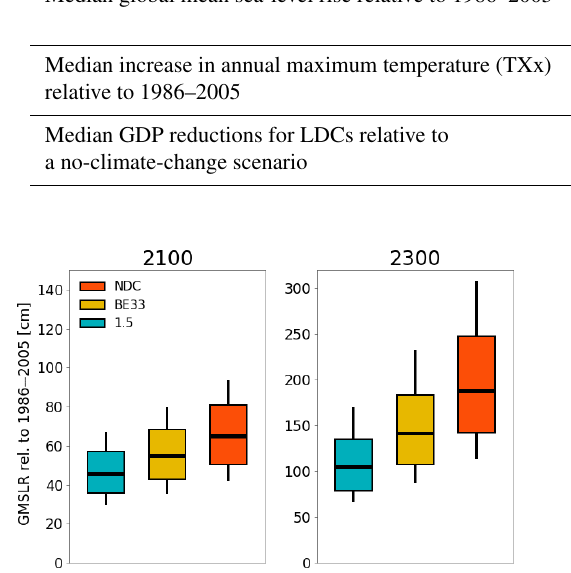
Figure 2. Global mean sea-level rise (GMSLR) projections un- der the NDC reference scenario (NDC), the CAT-based scenario for a 33% increase in NDC ambition of big emitters (BE33) and a scenario consistent with limiting 21st-century warming to 1.5 ◦ C (1.5 ◦ C) for the years 2100 and 2300 relative to the IPCC AR5 ref- erence period 1986–2005 in centimetres. Median values (thin hor- izontal lines) are provided together with the 66% model ranges (boxes) and 95% model ranges (whiskers). Please note the different y -axis